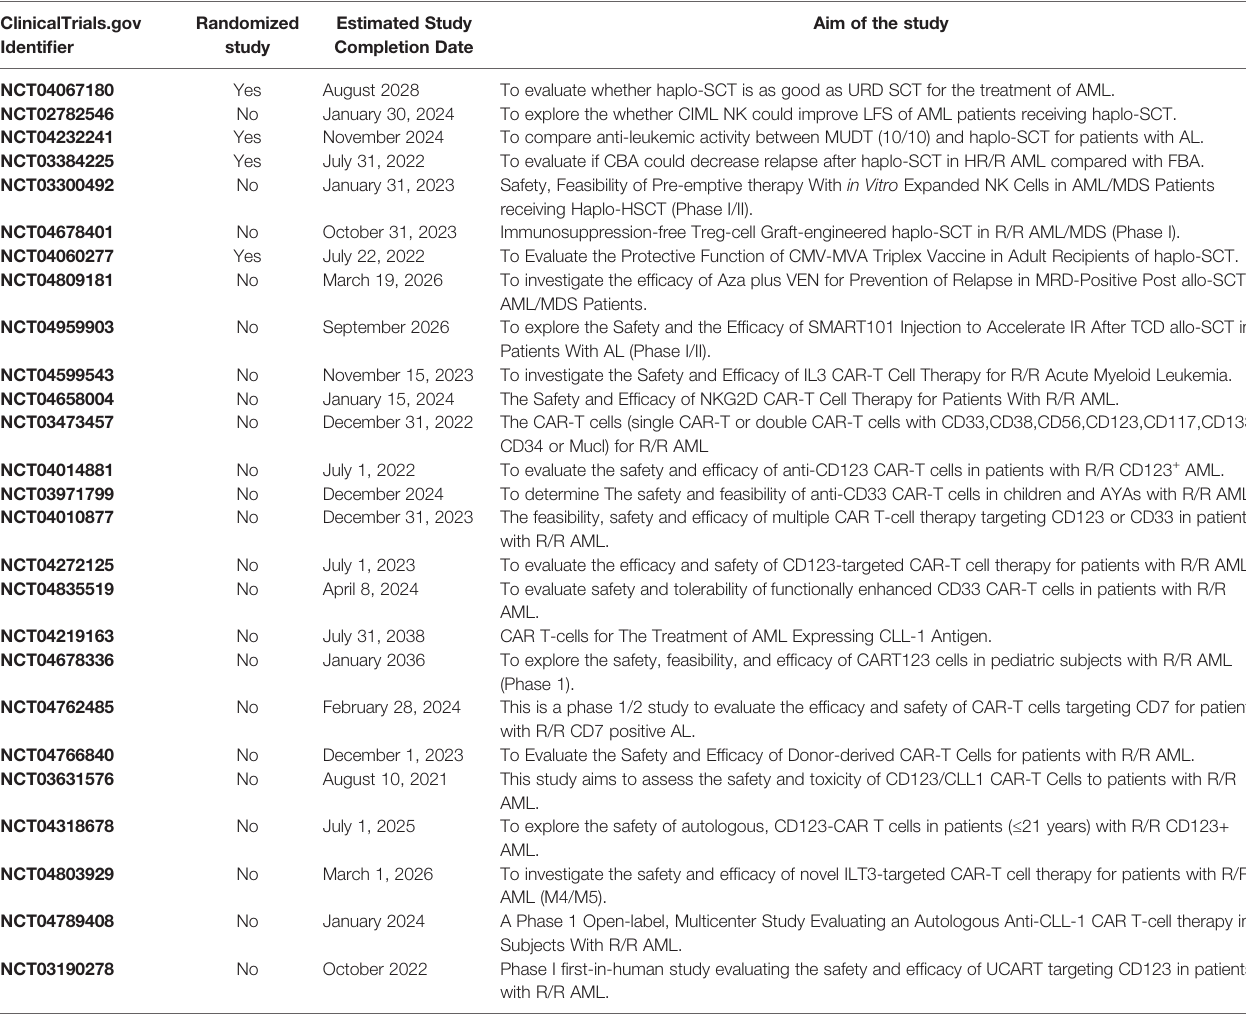
TABLE 4 | Ongoing clinical trials focusing on patients with R/R AML or those who received haplo-SCT. ClinicalTrials.gov Identi fi